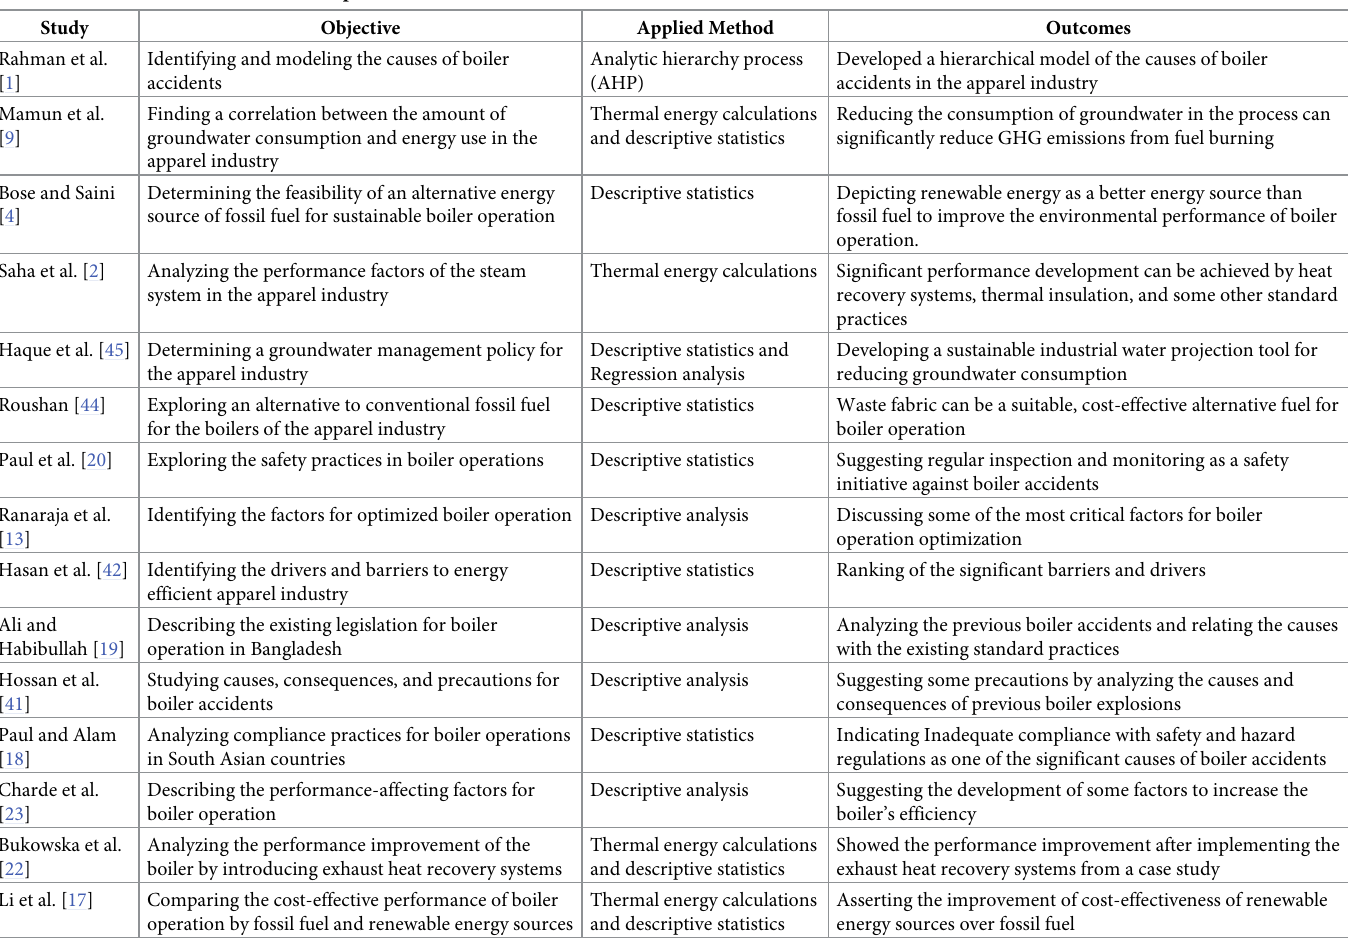
Table 1. Recent studies related to boiler